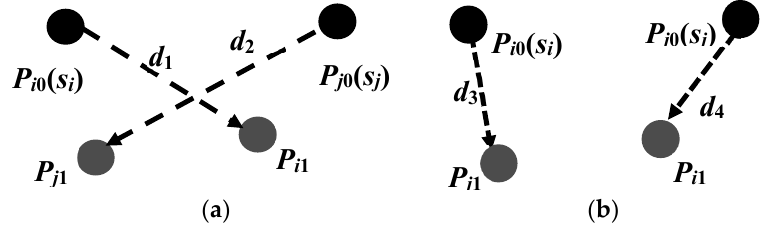
Figure 2. Candidate target positions exchange to reduce the average moving distance. ( a ) Before exchange; ( b ) After exchange.